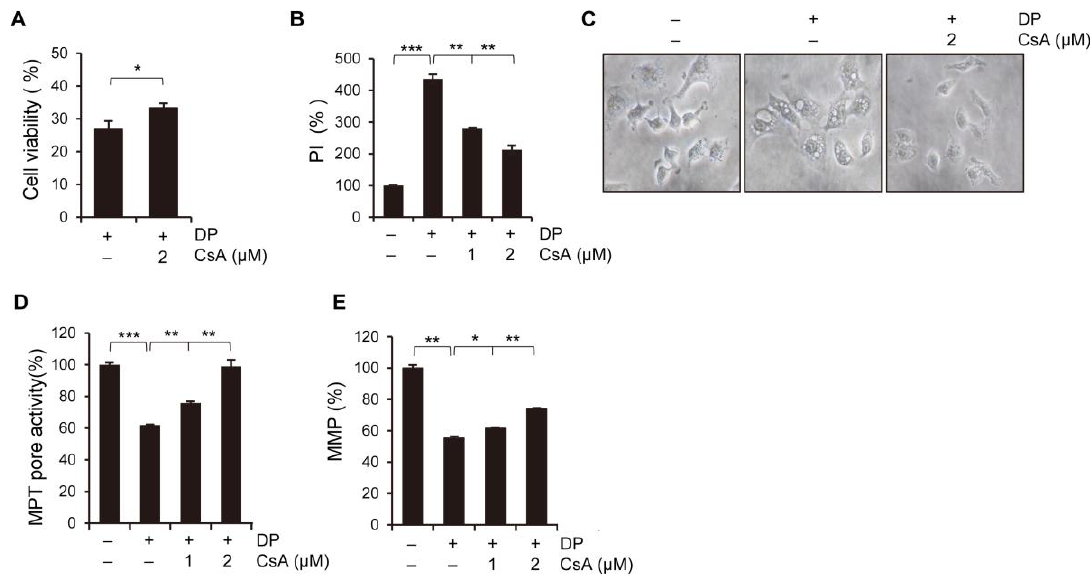
Figure 7. DP induces necrotic cell death via MPT-mediated mitochondrial Ca 2+ influx in A549